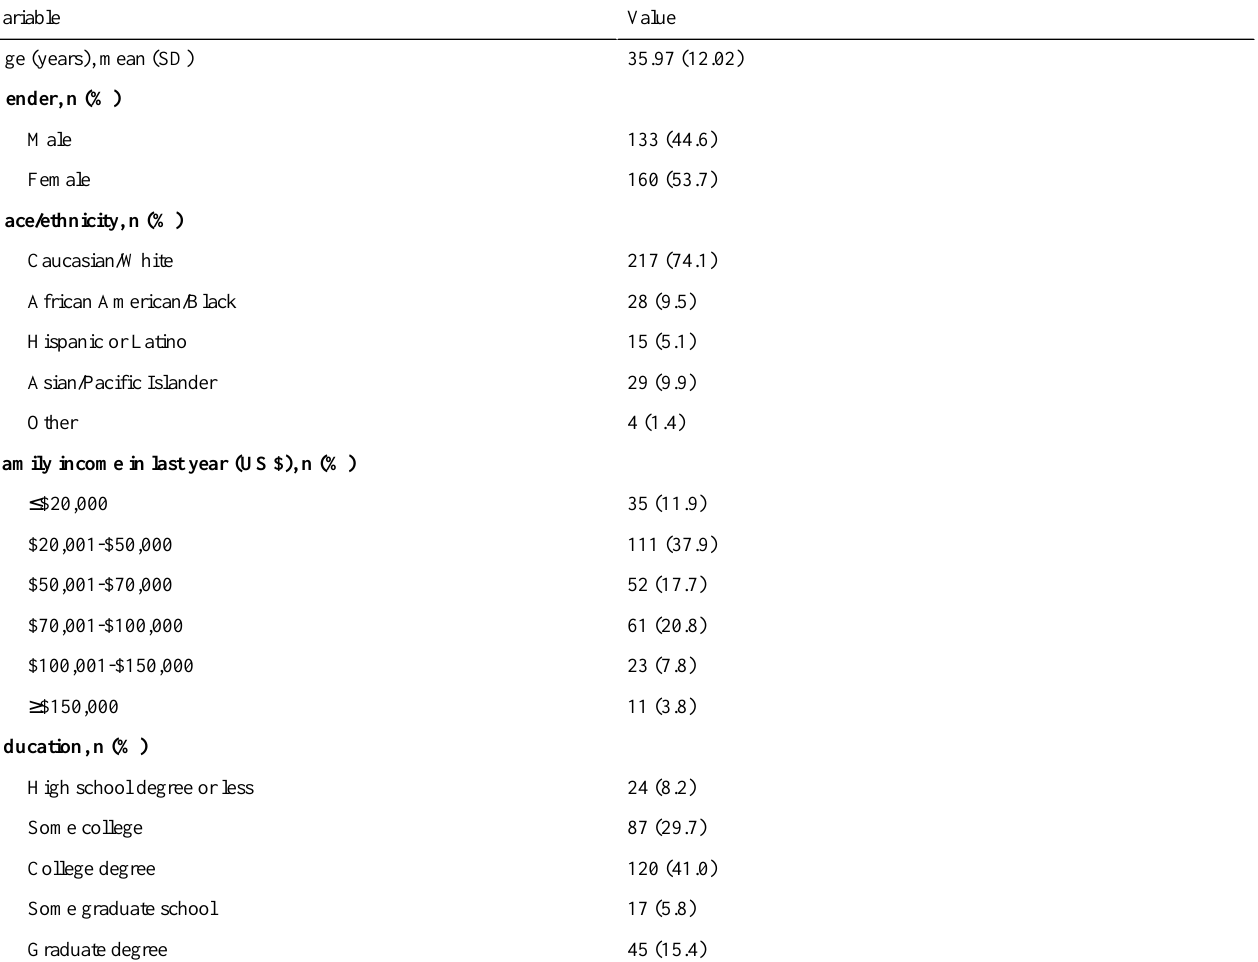
Table 1. Demographics of